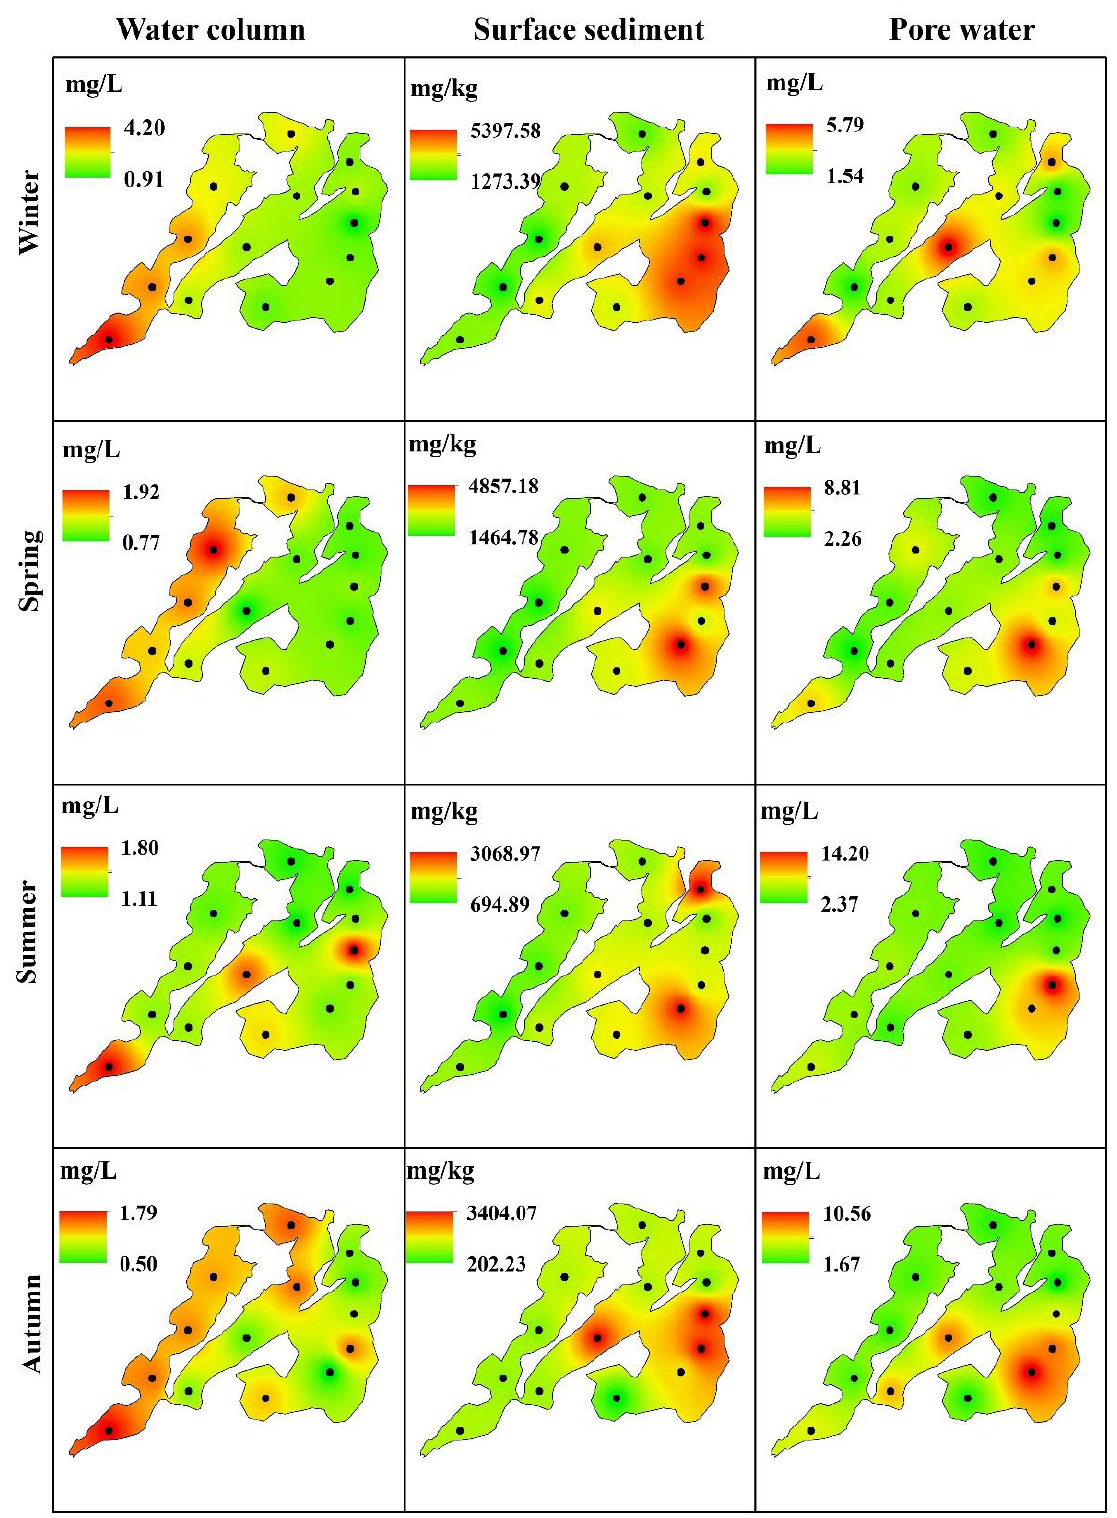
Figure 2. The seasonal variations of TN in the water column, surface sediment, and pore water displayed according to the values of 14 sampling sites in Lake Yangcheng. The colored areas indicate the concentrations of TN at the sampling sites. The color spectrum ranges from green (lowest) to red